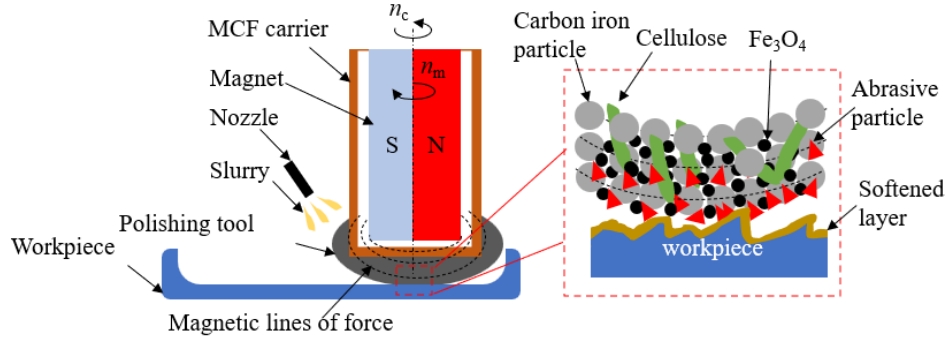
Figure 1. Schematic of the proposed polishing method.